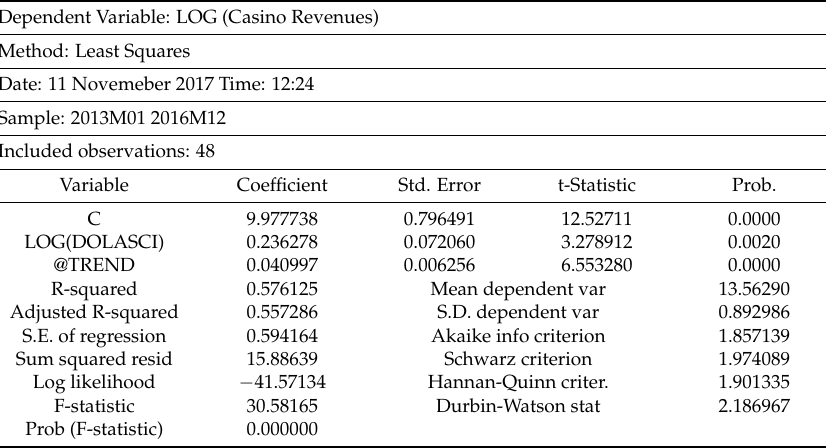
Table 6. Estimation of Regression